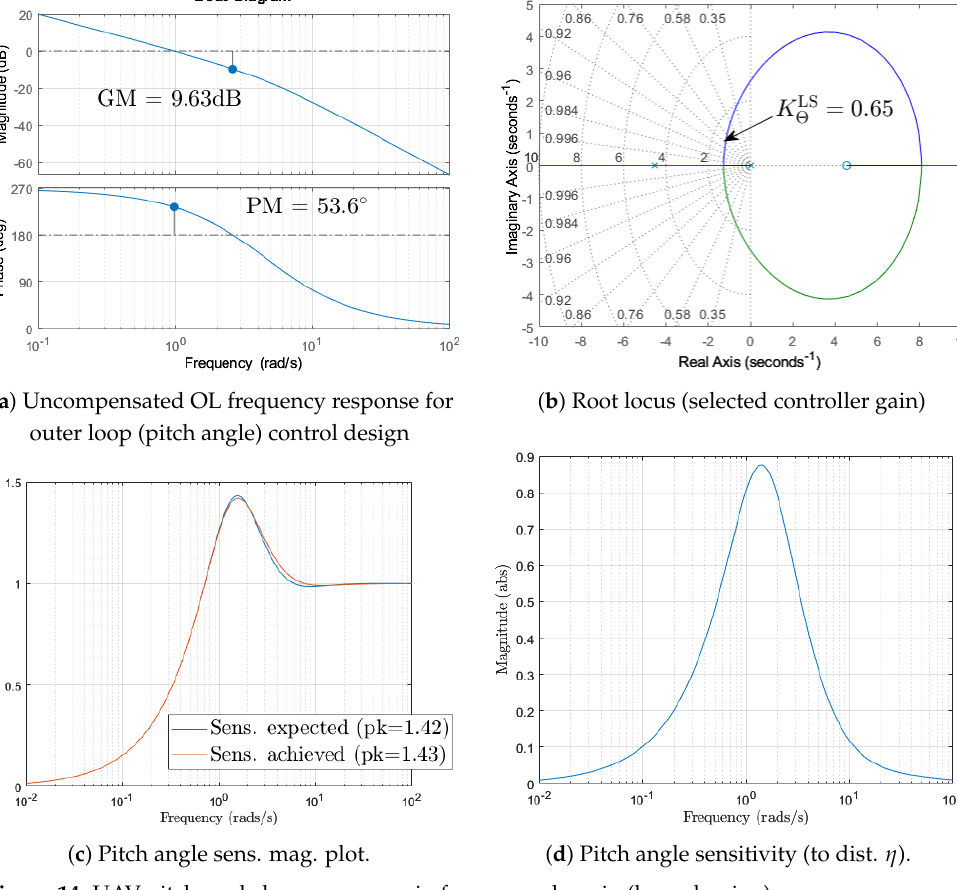
Figure 14. UAV pitch angle loop responses in frequency domain (loop